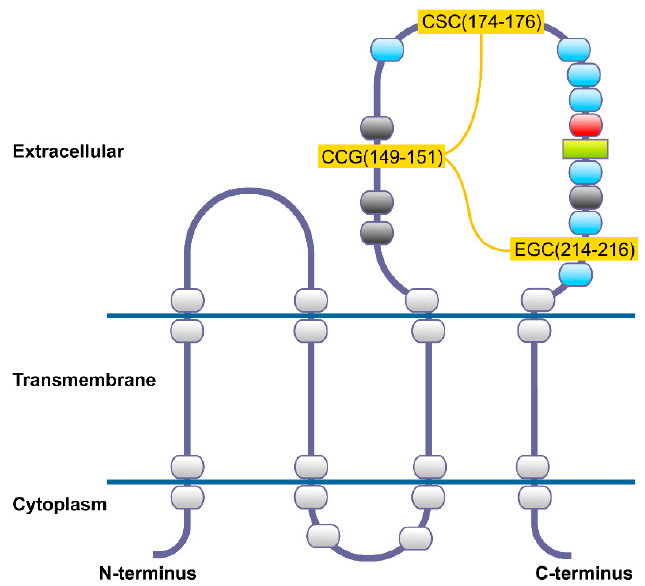
Figure 2. Schematic diagram of the CD82/KAI1 model showing the extracellular–transmembrane– cytoplasmic domains according to Bienstock and Barett [20]. Large extracellular domain contains cysteine protein motifs (CCG, CSC, and EGC) as yellow boxes with disulfide bonds shown as yellow lines. N-glycosylation sites are portrayed as dark grey boxes. The green rectangle represents another cysteine residue, red box depicts an asparagine residue and light blue boxes denote glutamine residues.